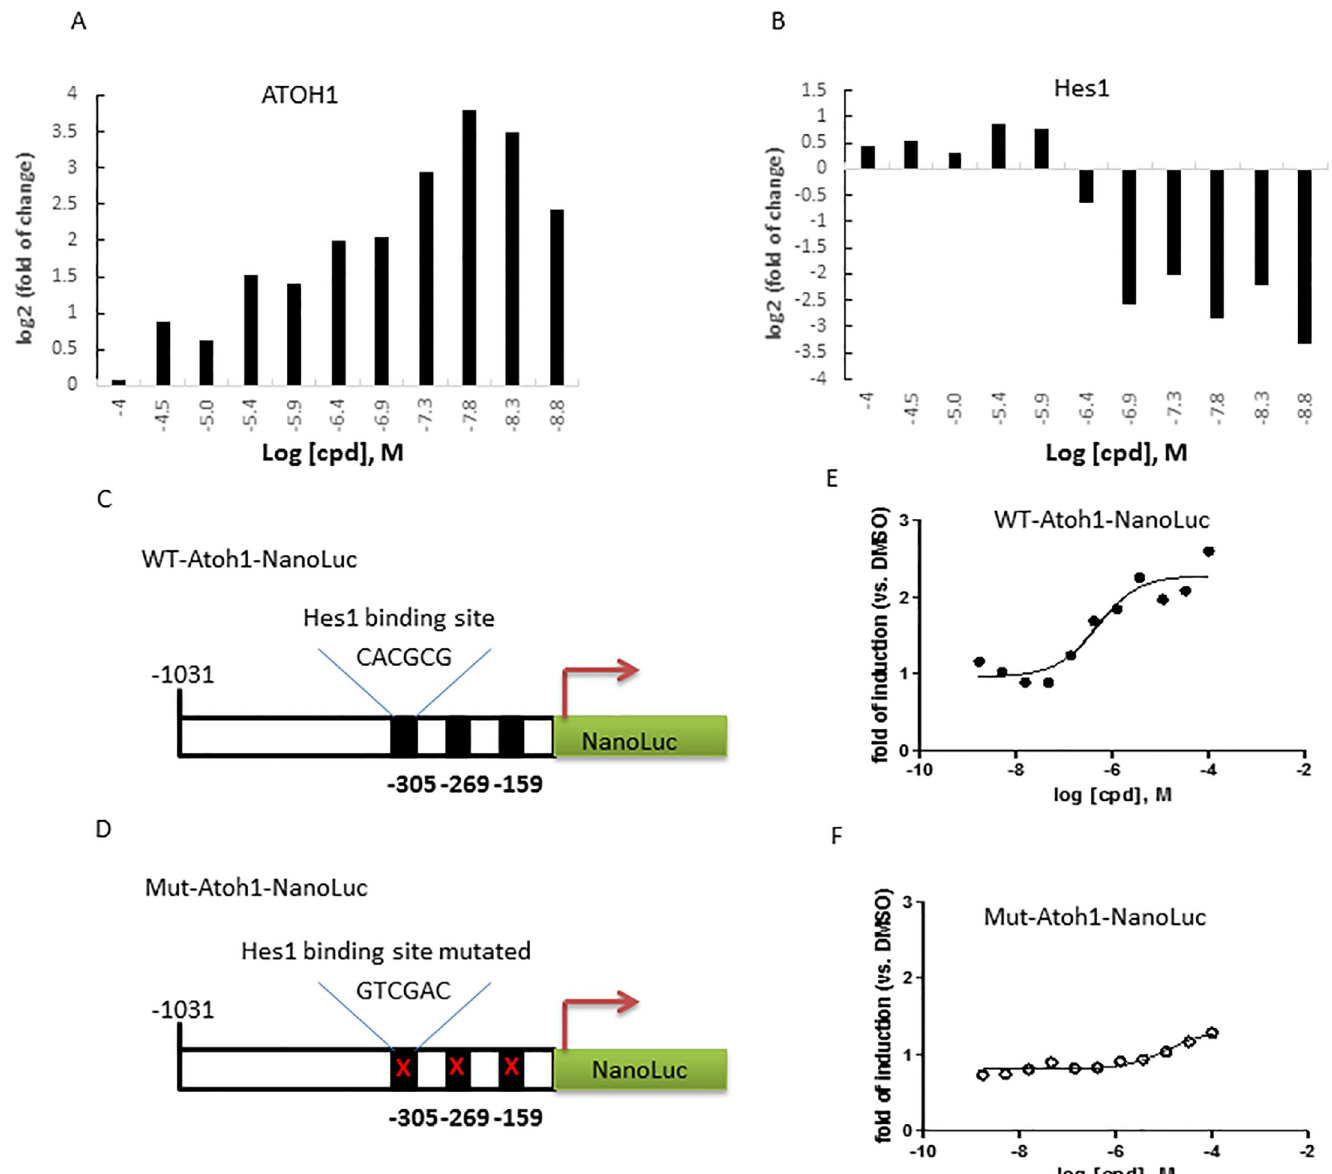
Fig 1. Validating the effect of GSI tool compound on Atoh1 and Hes1 gene expression and the Atoh1 promoter driven reporter in LS-174T cells. A and B. The endogenous Atoh 1 and Hes1 gene expression in LS-174T cells upon GSI compound II treatment was detected by Real-time RT-qPCR. LS-174T cells were treated with compounds at doses indicated for 72hrs and mRNA was extracted for RT-qPCR analysis using the corresponding primers against Atoh1 , Hes1 and GAPDH (housekeeping control, not shown). C and D. The design and validation the Atoh1 promoter-driven NanoLuc reporter assay. The WT Atoh1 promoter (-1031 to +2 of the endogenous Atoh1 gene regulatory region) was subcloned upstream of the NanoLuc luciferase reporter construct (WT- Hes1 -NanoLuc) (C) in a lentiviral vector backbone. The 3 copies of the Hes1 binding element CACGCG in the WT Atoh1 promoter region were mutated to GTCGAC in the mutant reporter (Mut- Atoh1 - NanoLuc) (D). E and F. The activities of the tool compound in the WT Atoh1 -NanoLuc (E) or Mut- Atoh1 -NanoLuc (F) reporter assays. The LS-174T cells were infected with Lentiviruses encoding either WT or Mut Atoh1 -NanoLuc reporter and plated on compound pre-stamped assay plate. The cells were lysed for NanoLuc activity measurement after 72hr